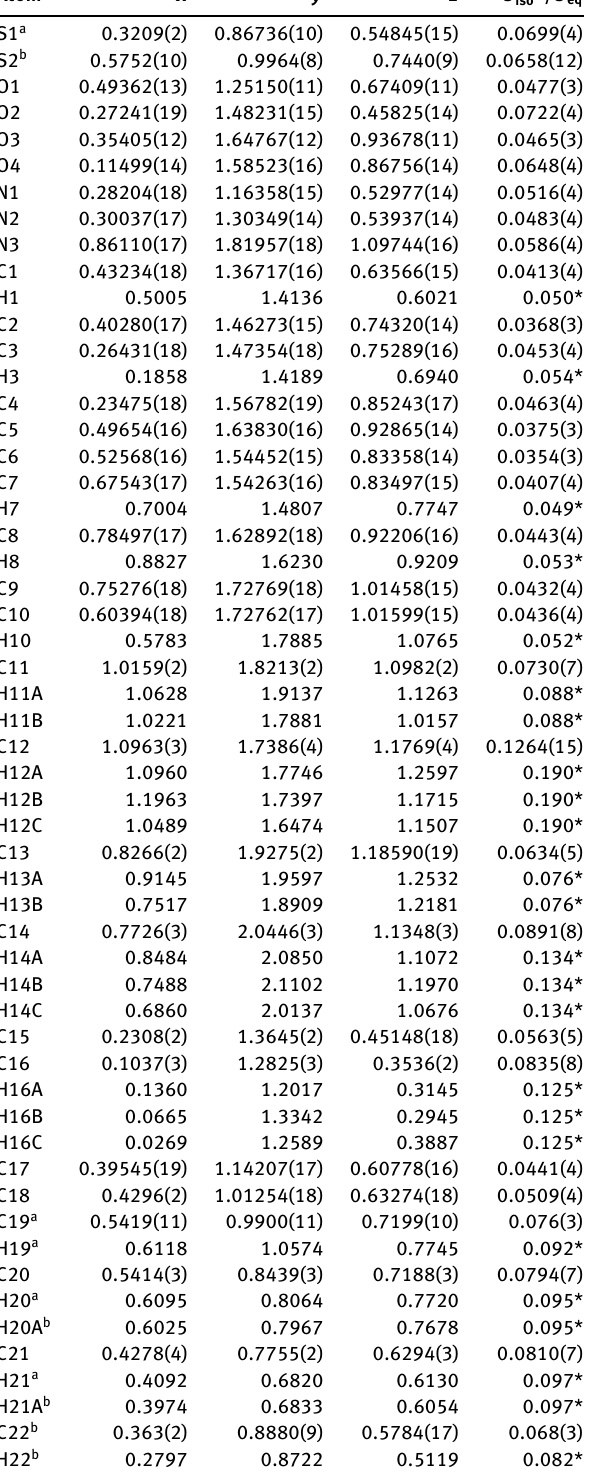
ring. The short C—N bond lengths of 1.277(2) Å (N1—C17) suggests a localized double bond, and the C—N bond lengths of 1.457(2) Å (N2—C1) suggests a localized single